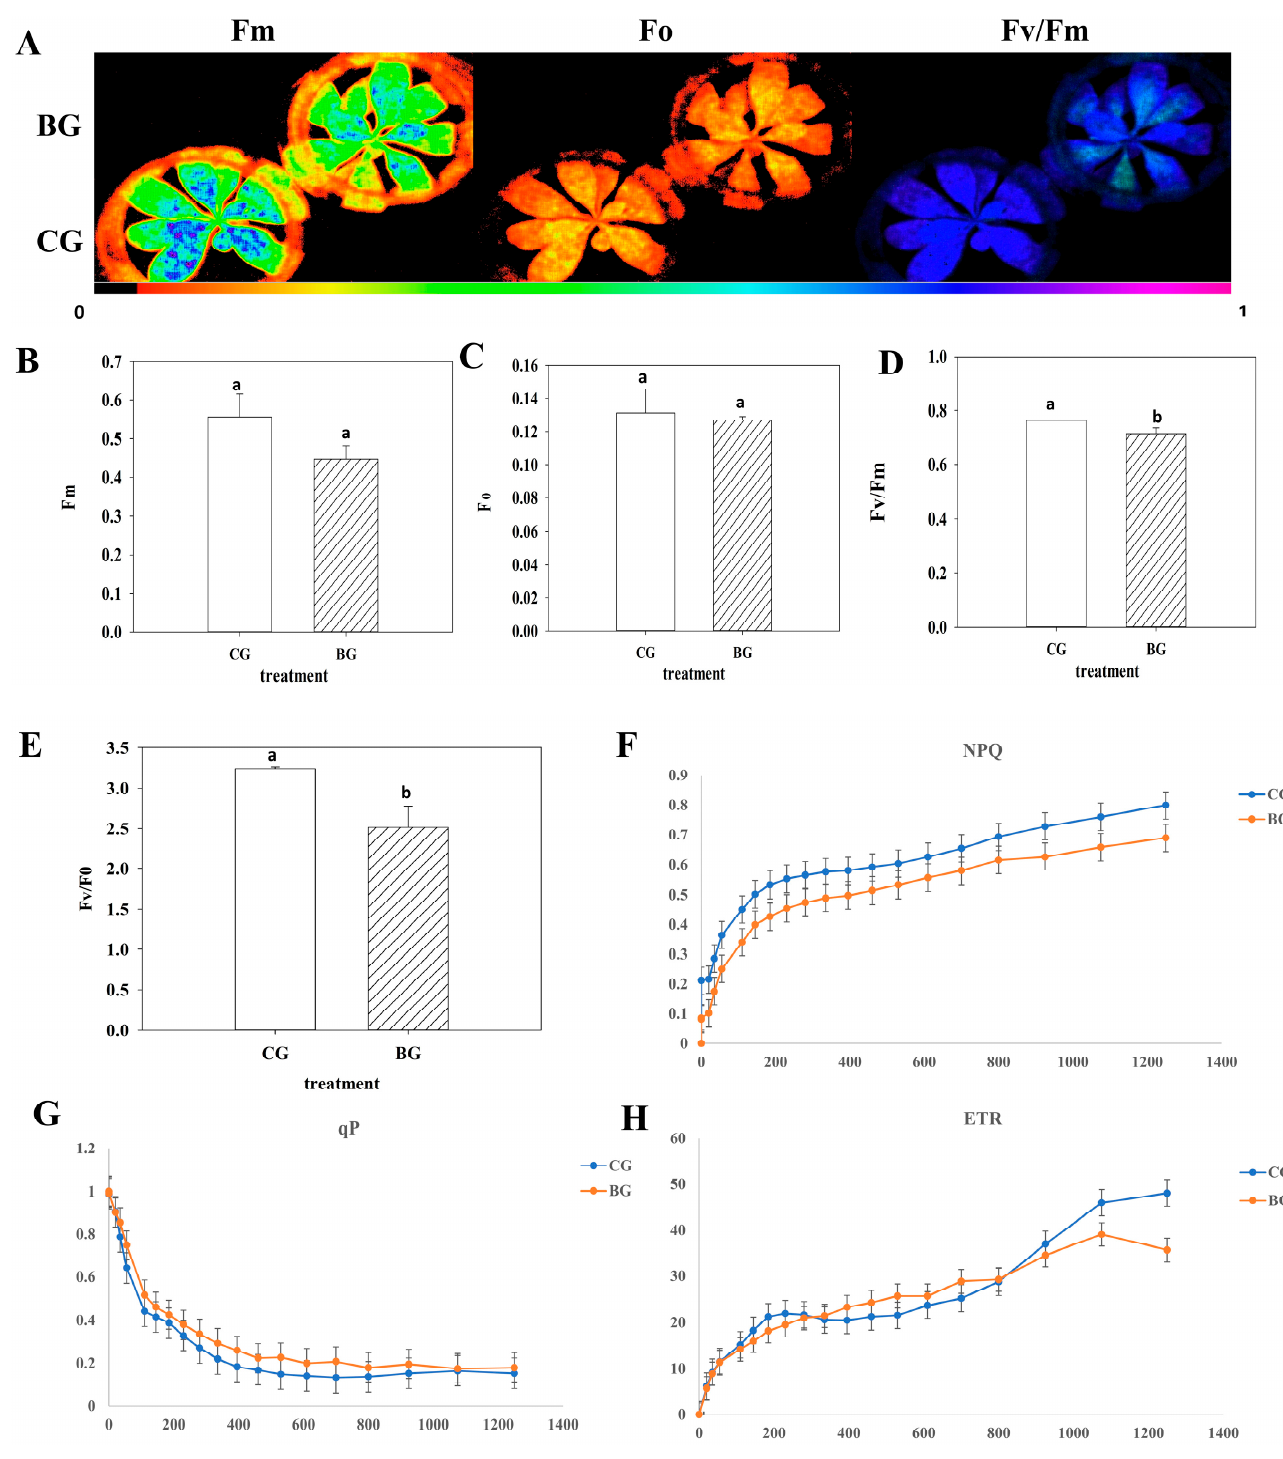
Figure 1. Photosynthetic characteristics in Rhododendron chrysanthum under UV-B stress. Lowercase letters denote significant differences between treatments ( p < 0.05). ( A ) Real-time fluorescence imaging of Rhododendron chrysanthum ; ( B ) maximal fluorescence (Fm); ( C ) initial minimum fluorescence ( D ) maximum quantum yield of PSII (Fv/Fm); ( E ) potential activity of optical system II (Fv/Fo); ( F ) mean nonphotochemical quenching (NPQ) as a function of PAR; ( G ) mean photochemical quenching (qP) as a function of PAR; ( H ) electron transportation rate (ETR).